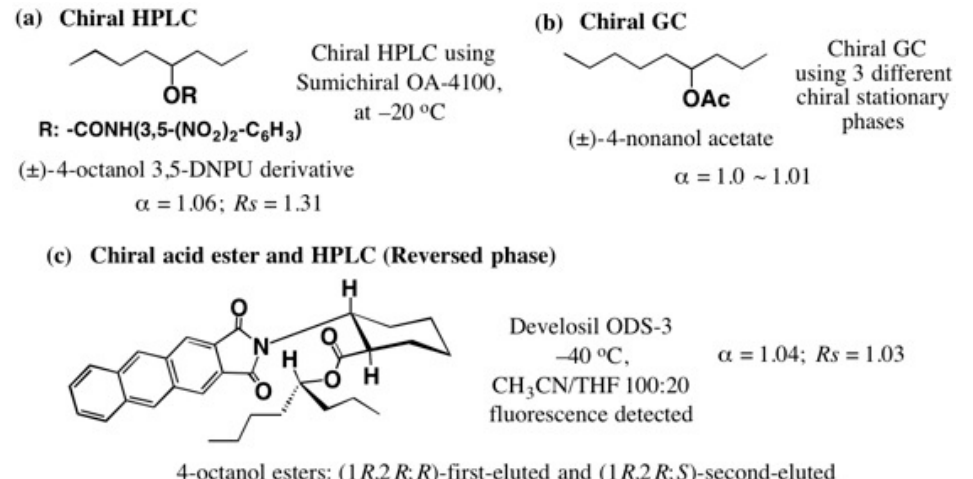
Figure 2. HPLC or gas chromatography (GC) separation of alkyl chain alcohol derivatives ( a )–( c ).